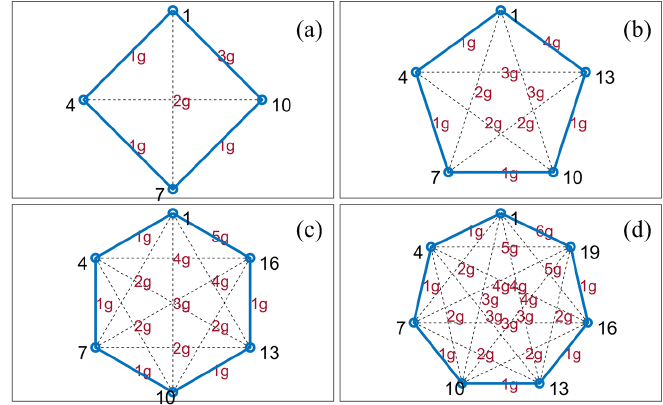
Figure 7. The distances between frequencies in the first column of the pseudo-random cyclic orthogonal sequence (PRCOS) with guard g = 3: ( a ) M = 4, N = 12 ( b ) M = 5, N = 15 ( c ) M = 6, N = 18 ( d ) M = 7, N = 21.